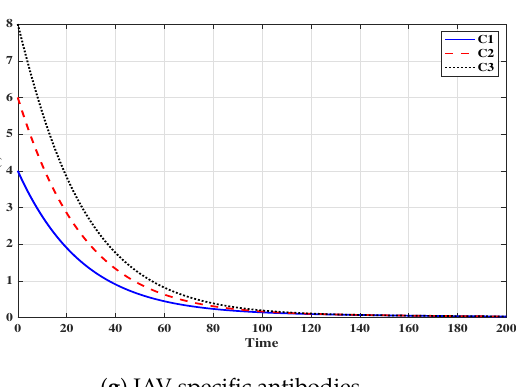
Figure 4. Solutions of system (3) with initials C1–C3 tend to Ξ 2 = ( 5,0,1.25,0,5,0,0 ) when (cid:60) 2 > 1 , (cid:60) (cid:60) ≤ 1 and (cid:60) ≤ 1 (Situation 2 1 / 4